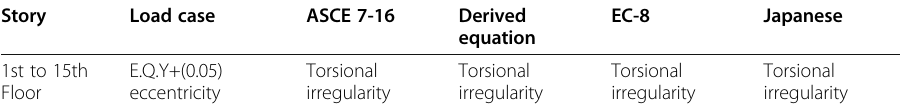
Table 14 Torsional irregularity check of 5th model due to ASCE 7-16, EC-8, Japanese, and derived